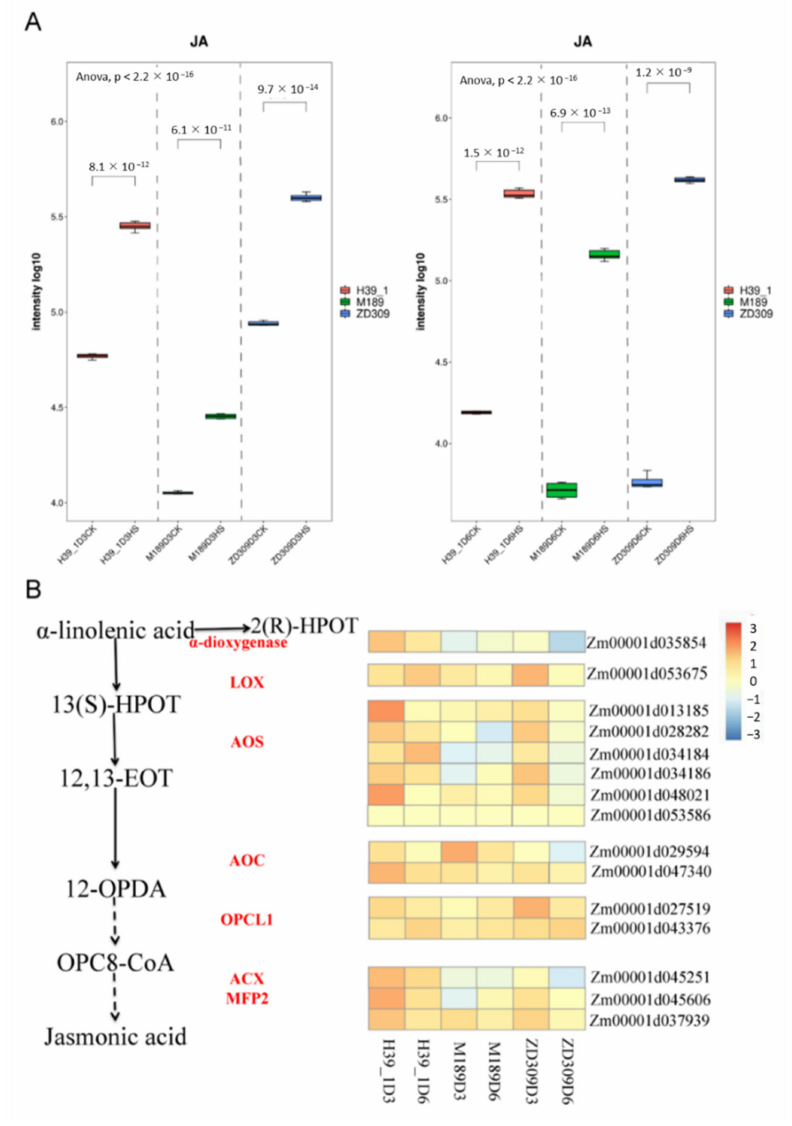
Figure 9. The alterations of JA levels and metabolism pathway-related genes expression levels in response to heat stress. ( A ) JA levels in three genotypes at both heat treatments; ( B ) The relative expression of the genes involved in JA biosynthesis. Data are presented as a heatmap by a log 2 transformed fold